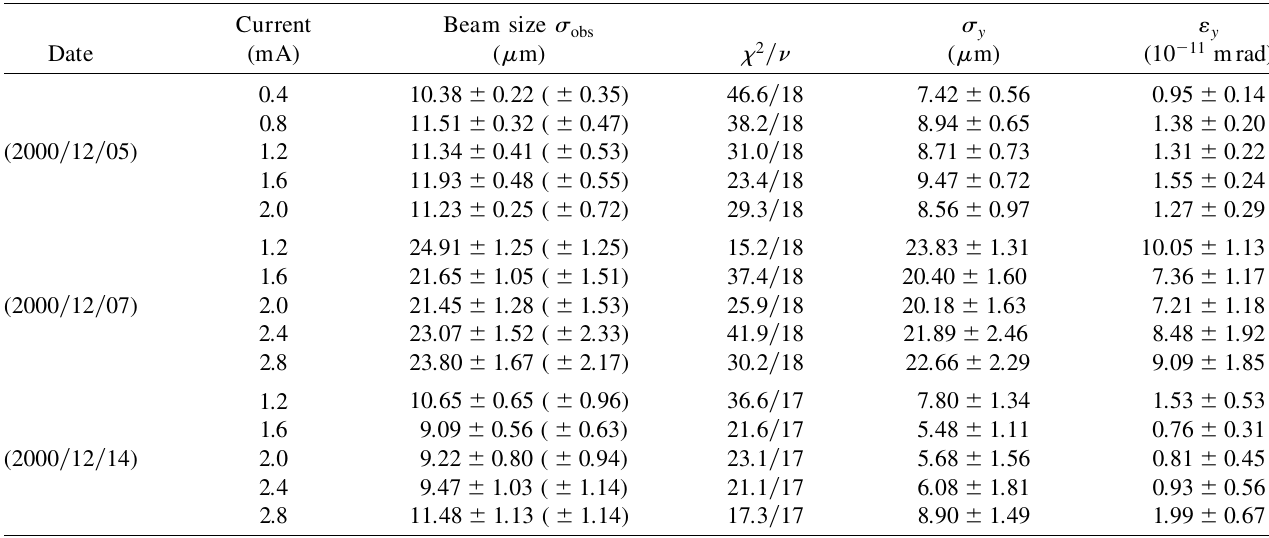
TABLE II. Summary of the electron beam size measurements.